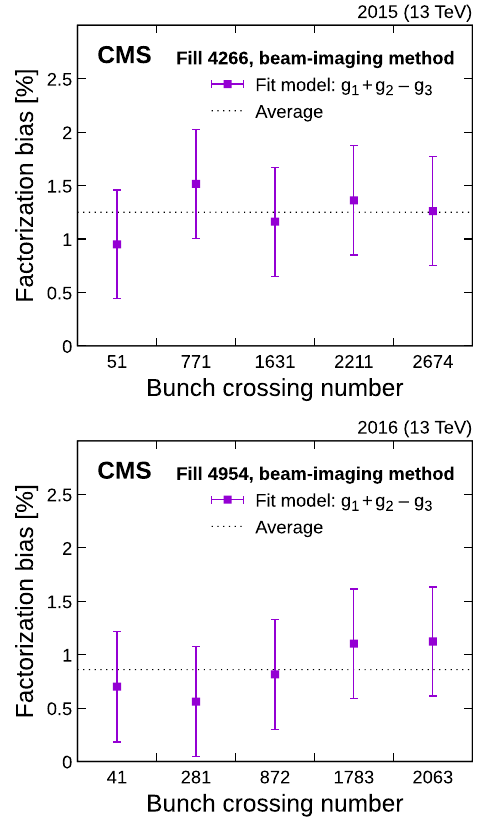
Fig. 12 Factorization bias estimated from the fits to the BI bunch-by- bunch data in fills 4266 (upper) and 4954 (lower). The error bars denote sources of uncertainty (statistical and systematic), added in quadrature, in the factorization bias estimates